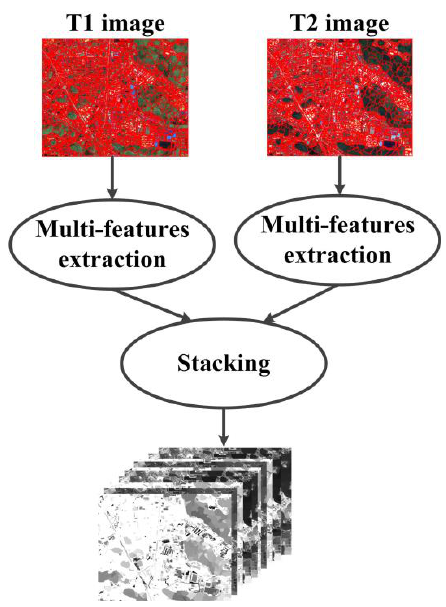
Figure 4. Multi-feature stacking scheme.